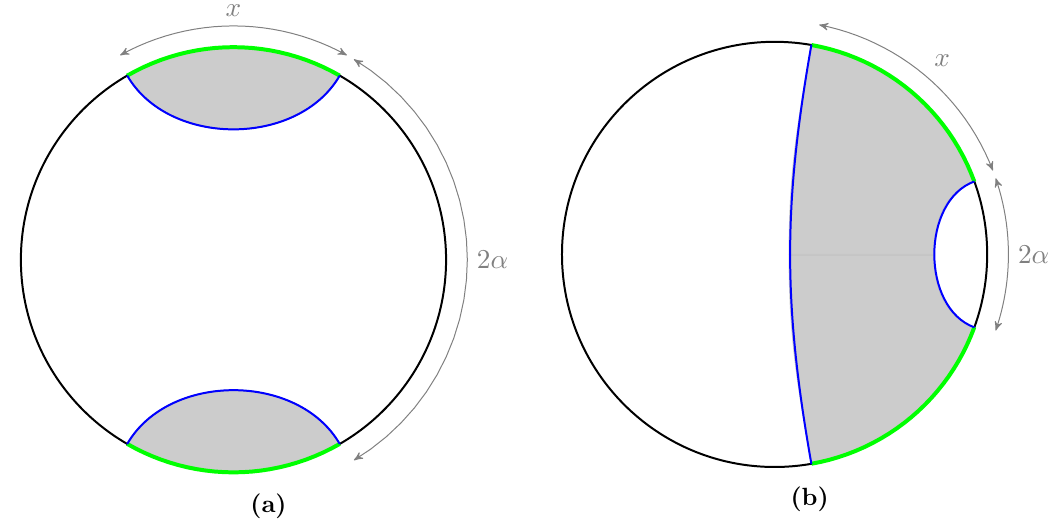
Figure 8. Minimal surfaces (shown in blue) for two intervals R 1 and R 2 (shown in green) of equal size x sitting on a constant time slice of AdS 2+1 . The intervals are separated by an angle 2 (cid:11) . The entanglement wedge E ( R 1 R 2 ) (shown in grey) is the region whose boundary is the union of the regions R 1 and R 2 and their minimal surfaces. For large (cid:11) and small x the entanglement wedge of the region R 1 [ R 2 is disconnected, while for small (cid:11) or large enough x , the entanglement wedge becomes connected, as shown at right. The entanglement wedge being connected indicates the mutual information is O ( N 2 ), while a disconnected entanglement wedge indicates the mutual information is O ( N 0